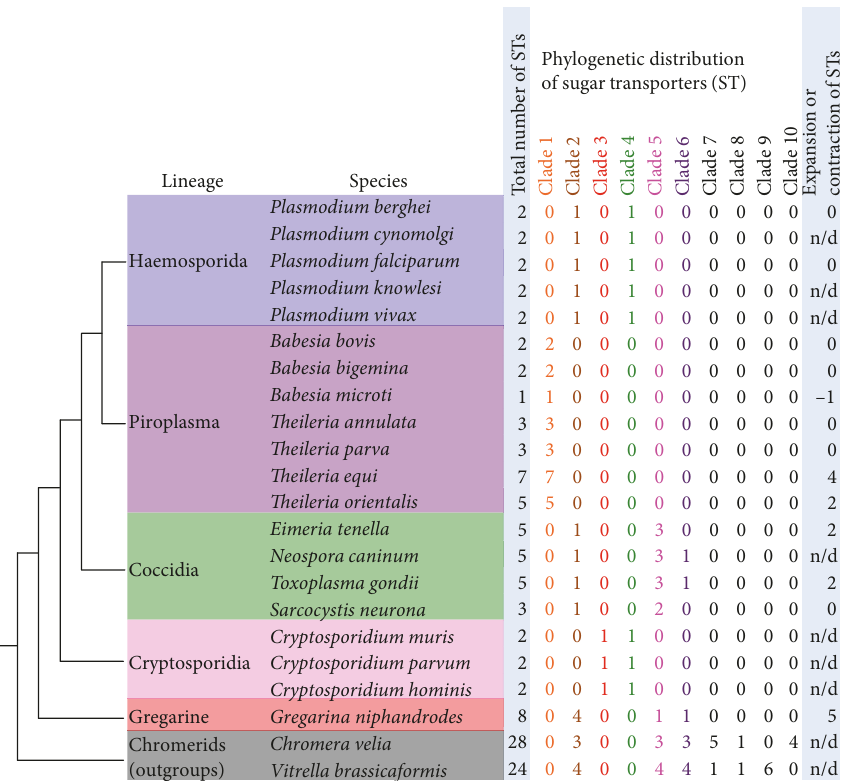
Figure 1: Distribution of apicomplexan sugar transporter (ST) gene family members. Left — cladogram shows relationships among apicomplexan lineages/species (Haemosporidia, Piroplasma, Coccidia, Cryptosporidia, and Gregarina niphandrodes ) and their free-living outgroups: Chromera velia and Vitrella brassicaformis (Chromerids). Right — the fi rst column lists the size of the sugar transporter gene family. The last column lists estimated expansion/contraction of sugar transporters in each species (see Supplementary Figure 1). Clades 2 and 5 have low bootstrap support in deeper branches (see Figure 2). n/d: not